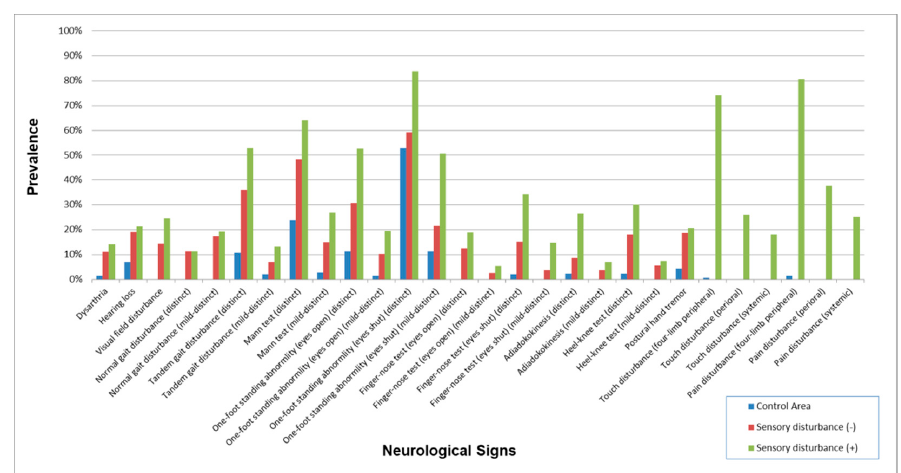
Figure 16. Prevalence of symptoms (Always and Sometimes) in subjects with and without sensory disturbance. The prevalence of symptoms was a little lower in subjects without sensory disturbance than in subjects with sensory disturbance but was apparently higher than the Control Area. The prevalence patterns were similar in exposed subjects with and without sensory disturbance. Toxics 2018 , 6 , x FOR PEER REVIEW